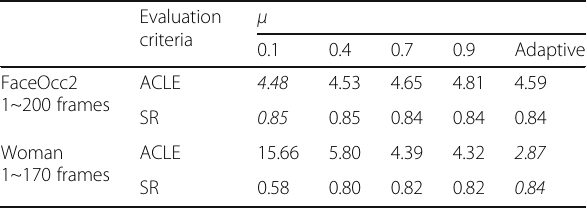
Table 4 Discussion of constant and adaptive parameter μ . The best results are shown in